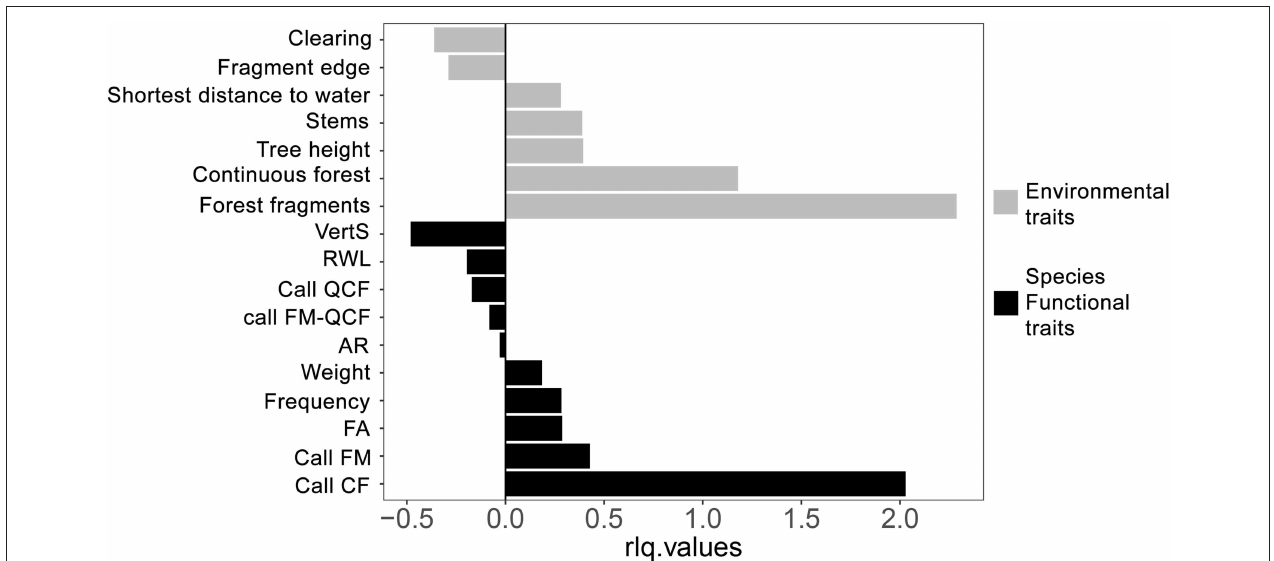
FIGURE 4 | Eigenvalues of species traits and environmental variables along the first axis of the RLQ analysis. See Table 1 for trait